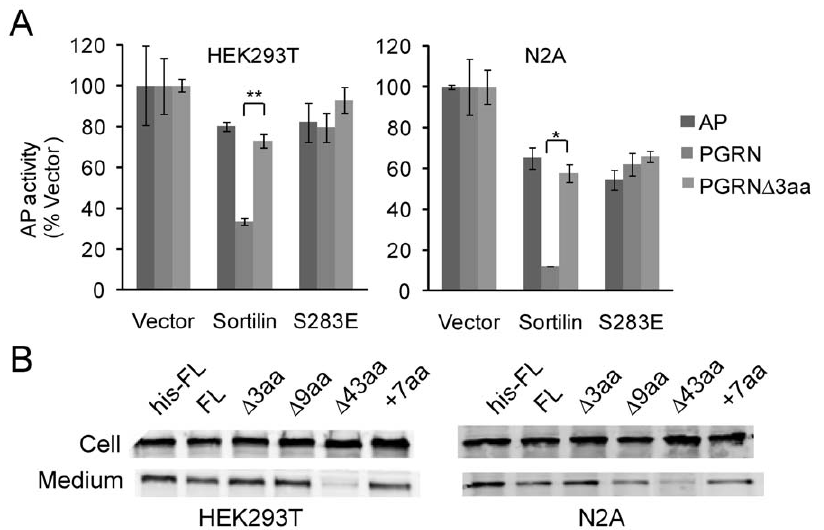
Figure 5. Deletion of progranulin C-terminal tail abolishes sortilin dependent control of progranulin trafficking but does not affect progranulin secretion. ( A ) Deletion of the PGRN C-terminal 3 residues (PGRN D 3aa) or S283E mutation in sortilin abolishes sortilin dependent control of PGRN trafficking. AP tagged full length progranulin (FL), PGRN D 3aa (-3aa) or AP alone were co-transfected with pcDNA vector control, wild type or S283E mutant of sortilin into HEK 293T cells or N2A cells. The AP activities in the medium were measured 4 days after transfection. The AP activities in sortilin expressing cells were expressed as percentage of vector control. *, p , 0.05;**, p , 0.01, n=3–5, paired Student’s T-test. ( B ) Deletion of progranulin C-terminal residues does not affect progranulin secretion. Progranulin expression constructs as AP fusion proteins were transfected in HEK293T and N2Acells. Progranulin levels in the cell lysates and media were determined by western blots using anti-AP antibodies.